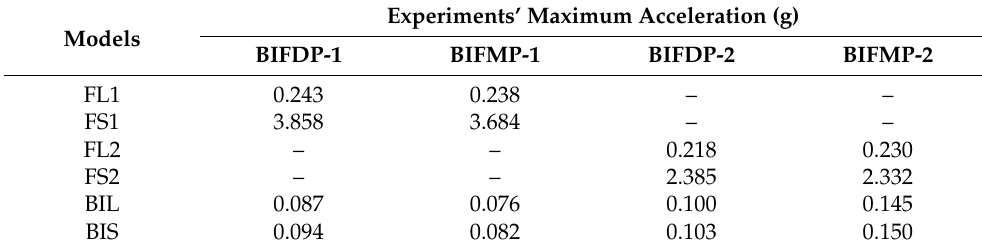
Figure 7. Responses of DP and MP in flexible base-isolated models. Table 7. Maximum responses in flexible base-isolated models.